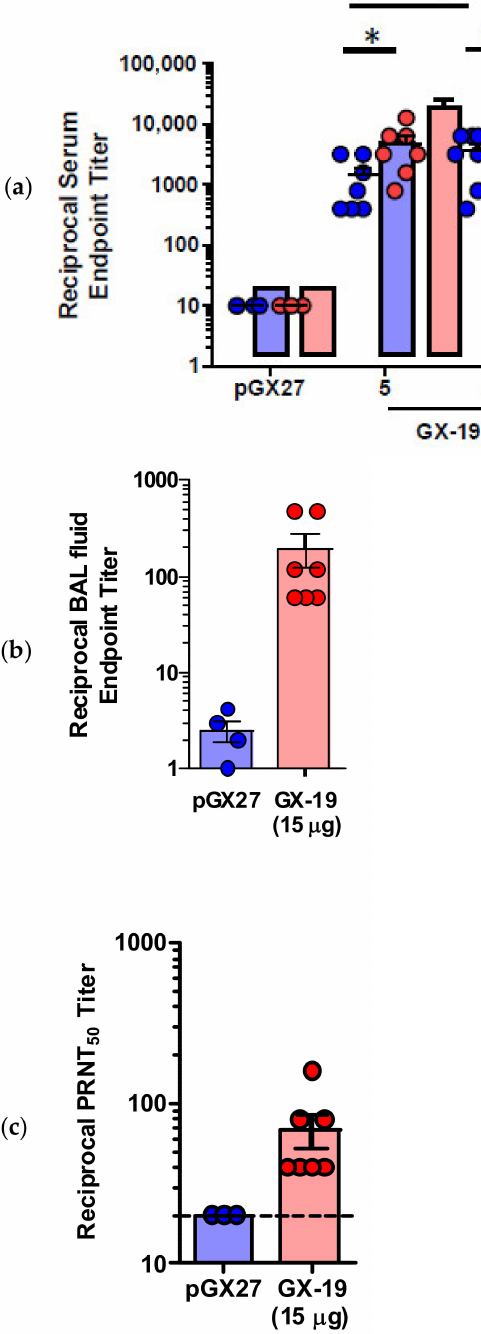
Figure 2. GX-19 elicits robust binding and neutralizing antibody responses in mice. BALB/c mice ( n = 4–7/group) were immunized at weeks 0 and 2 with indicated doses of GX-19 or pGX27 as described in the Methods ( a – c ). Sera were collected at 2 weeks post-prime (blue) and 2 weeks post- boost (red) and assessed for SARS-CoV-2 S-specific IgG antibodies by ELISA ( a ), and for post-boost sera, neutralizing antibodies against SARS-CoV-2 live virus ( c ). Bronchoalveolar lavages (BALs) were collected at 2 weeks post-boost and assayed for SARS-CoV-2 S-specific IgG antibodies by ELISA ( b ). Data representative of two independent experiments. All data are represented as individual values. * p < 0.05, ** p < 0.01 as determined by the Mann–Whitney